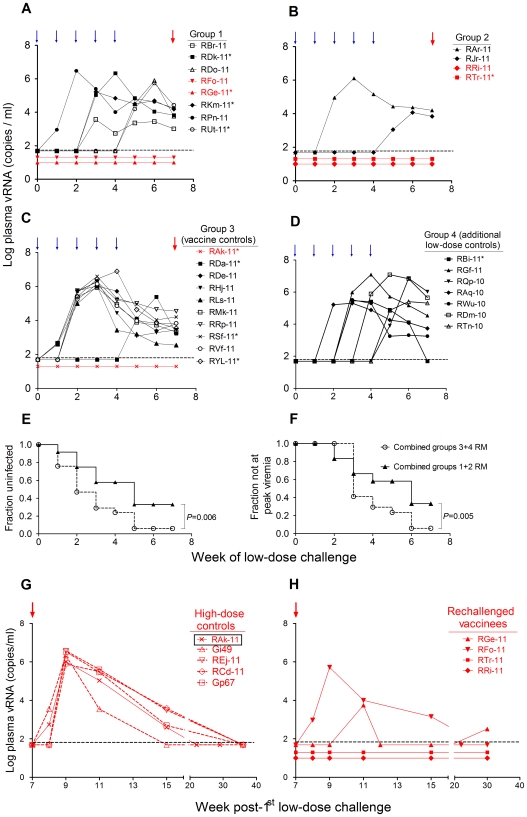
Plasma viral RNA (vRNA) loads after SHIV-1157ipEL-p challenges and Kaplan-Meier plots.(A–D) vRNA loads after low-dose viral challenges for Groups 1-4. Black symbols, vRNA loads of Groups 1-4 during the weekly low-dose challenges (blue arrows); red symbols, vRNA loads of animals later given high-dose challenge (red arrows; see also Figure 1 legend). (E) Kaplan-Meier plots depicting the fraction of monkeys remaining aviremic. (F) Kaplan-Meier plots depicting the fraction of animals not yet having reached peak viremia. (G–H) vRNA loads after a single high-dose SHIV-1157ipEL-p challenge of newly recruited naïve controls (Group 5) plus prior control monkey RAk-11 (G), or rechallenge of vaccinees (H). Probability (P) values were determined by 2-sided log-rank analysis. Horizontal dashed lines in A–D, G–H: limit of RT-PCR assay detection (50 vRNA copies/ml; [25]).